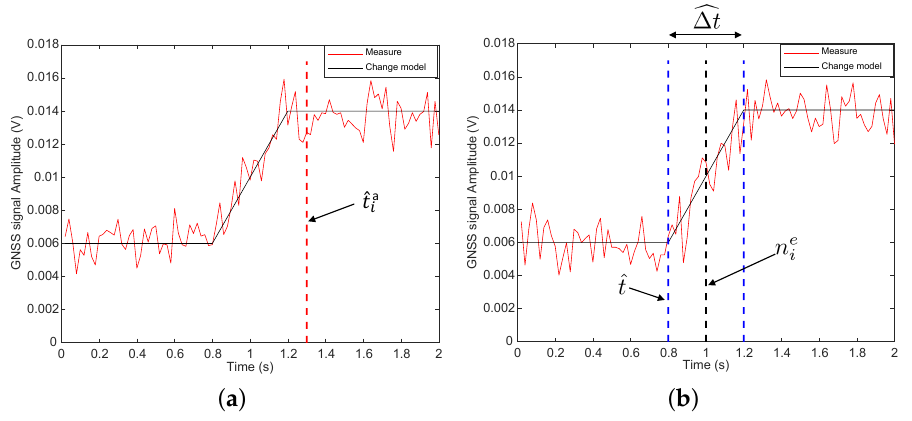
Figure 8. Change detection and localization. ( a ) change detection, ( b ) change localization.